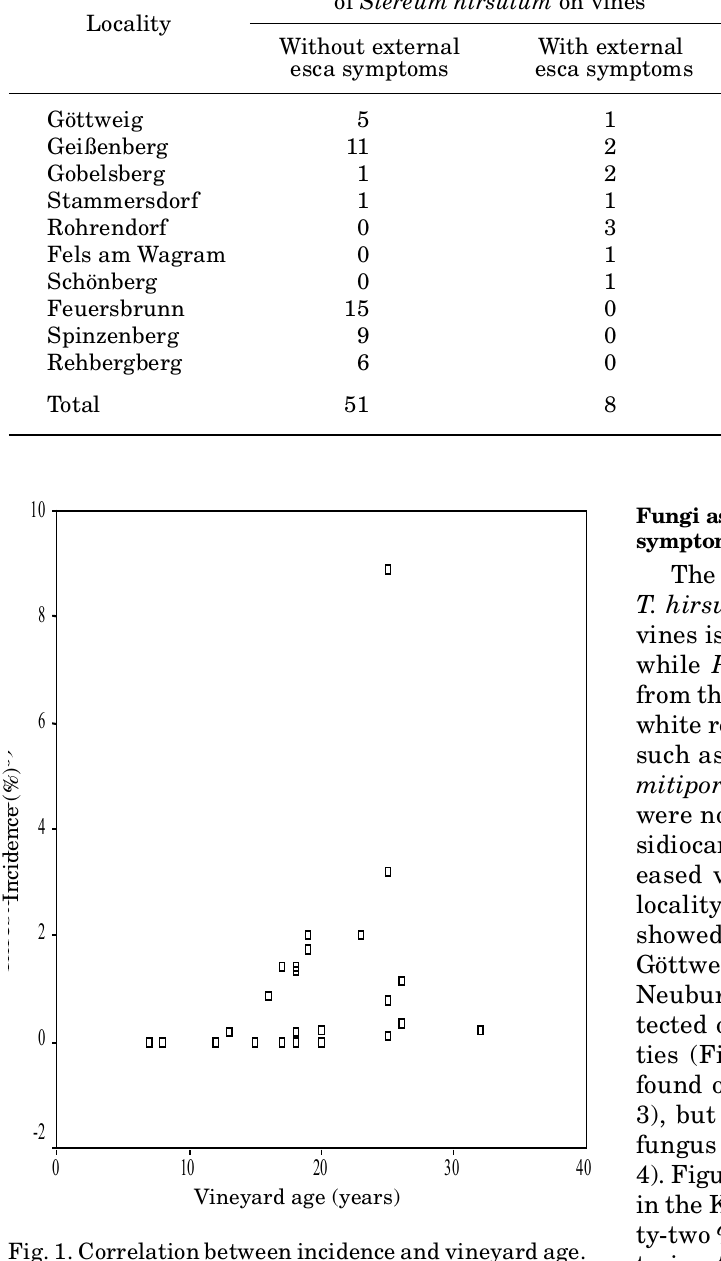
Fig. 1. Correlation between incidence and vineyard age. Incidence is expressed as the percentage of diseased vines (external symptoms) in each vineyard. The non- parametric Spearman-Rho – test showed a positive cor- relation between incidence and vineyard age (the corre- lation coefficient was 0.583, significant at P